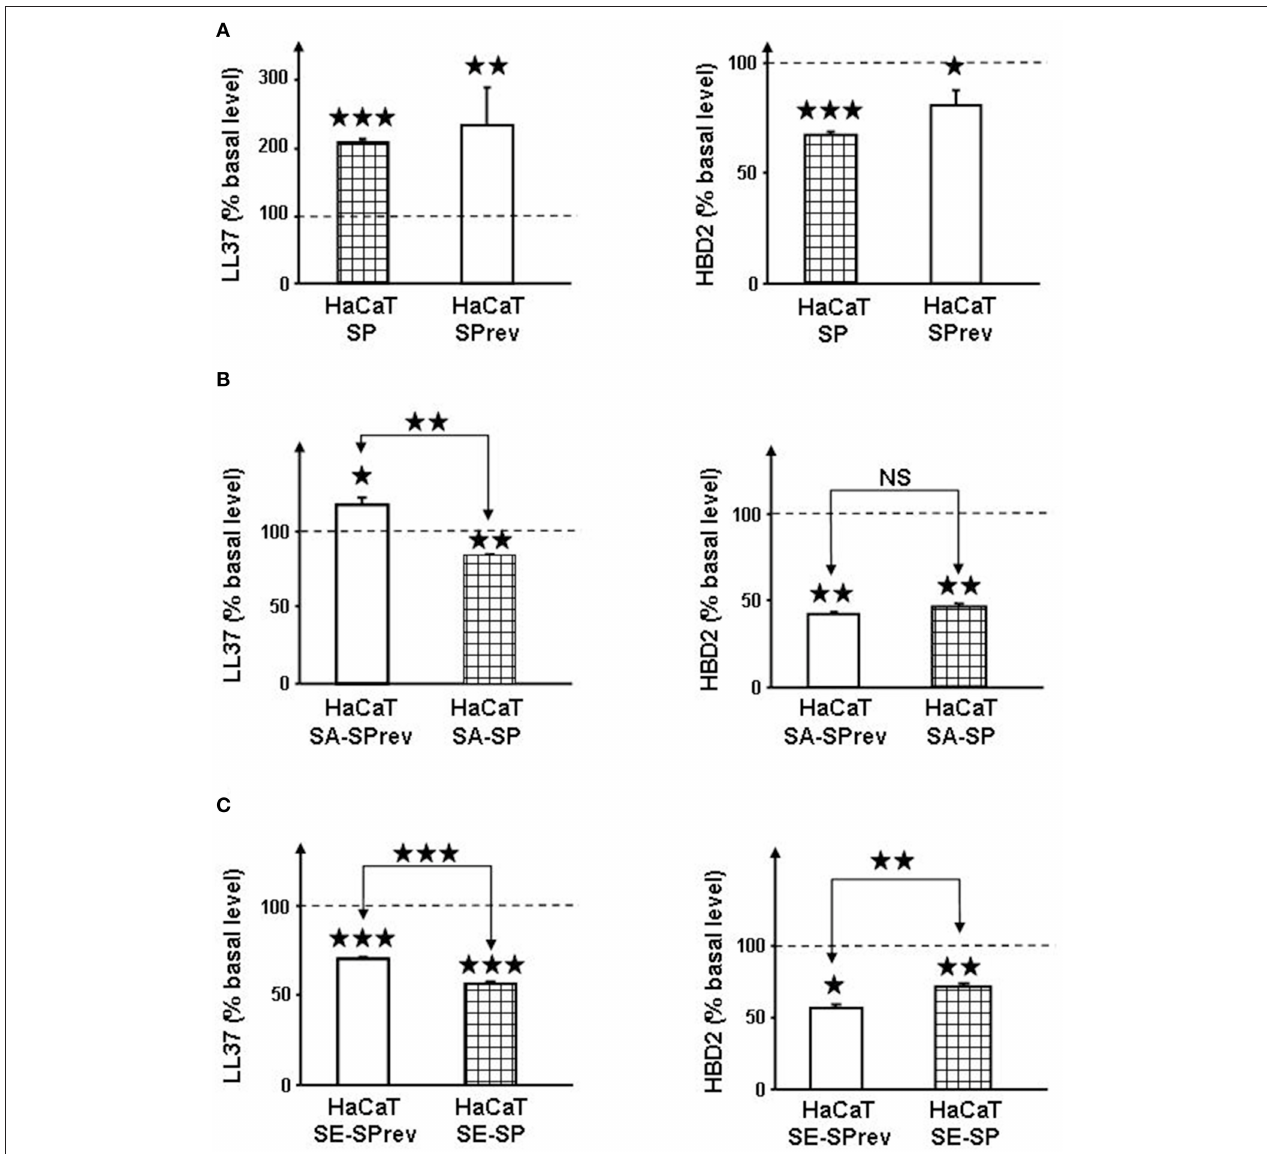
FIGURE 3 | Effect of Substance P (SP) and Substance P reverse (SPrev) (A), Substance P reverse (SA-SPrev) and Substance P treated S. aureus (SA-SP) (B) and Substance P reverse (SE-SPrev) and Substance P treated S. epidermidis (SE-SP) (C) on cathelicidin LL37 and β -defensin 2 production by HaCaT keratinocytes. On each figures, dotted lines indicate the basal production of LL37 and HBD2 by HaCaT in the absence of treatment (control). Each value is the mean ± SEM of three independent experiments. (NS = non significant; ⋆ p < 0.05; ⋆⋆ p < 0.01; ⋆⋆⋆ p < 0.001).